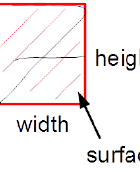
Figure 7. Representation of the parameter “REGANGLE”.